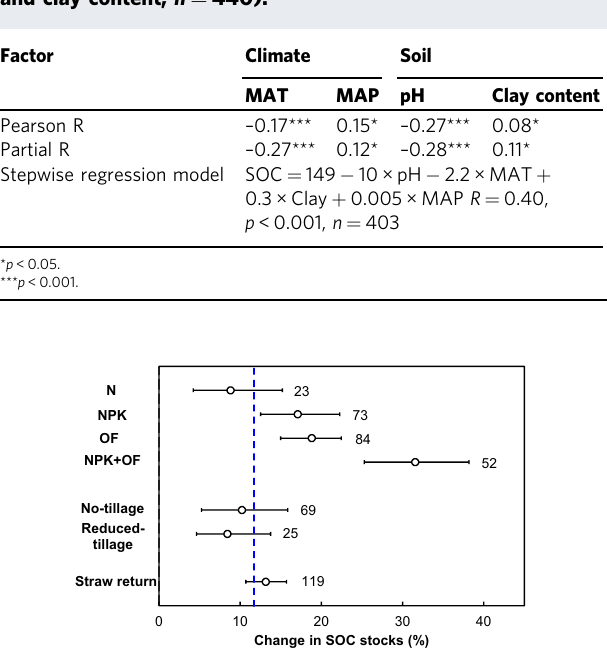
Fig. 3 Results of a meta-analysis on the effects of management practices on paddy SOC stocks (0 – 30cm). Error bars indicate 95% con fi dence intervals. The number of observations included in the meta-analysis is shown next to the corresponding data point. OF organic fertilizer. Dashed vertical line shows the average of all agronomical practices on the SOC increase. The effects of all presented management practices are signi fi cant ( p <